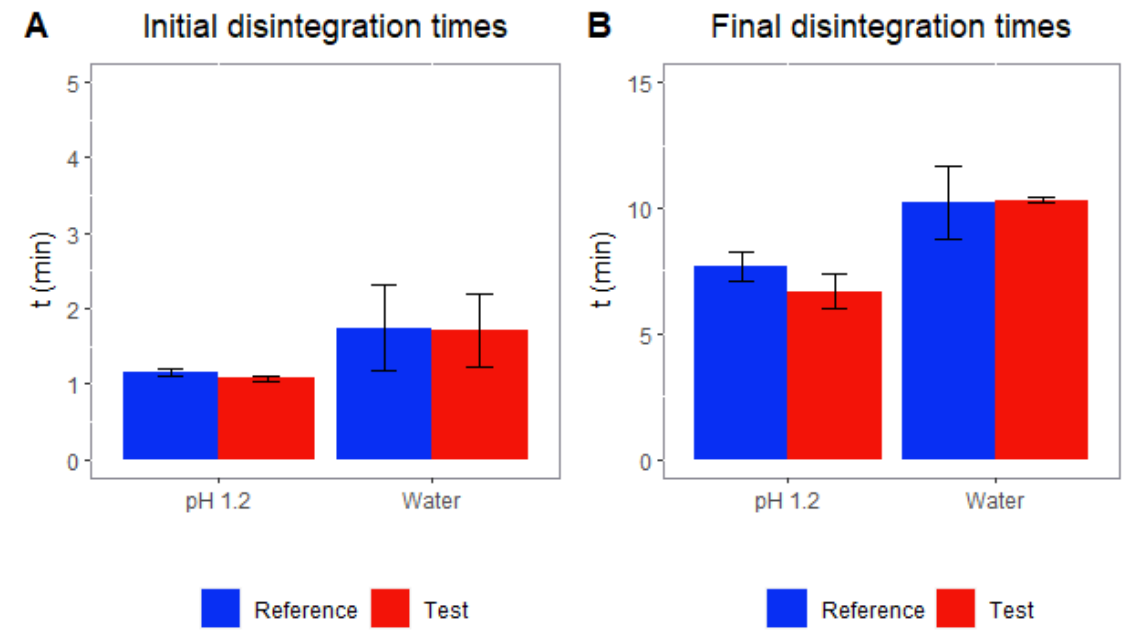
Figure 3. Disintegration times for reference product and test product in water and buffer at pH 1.2.